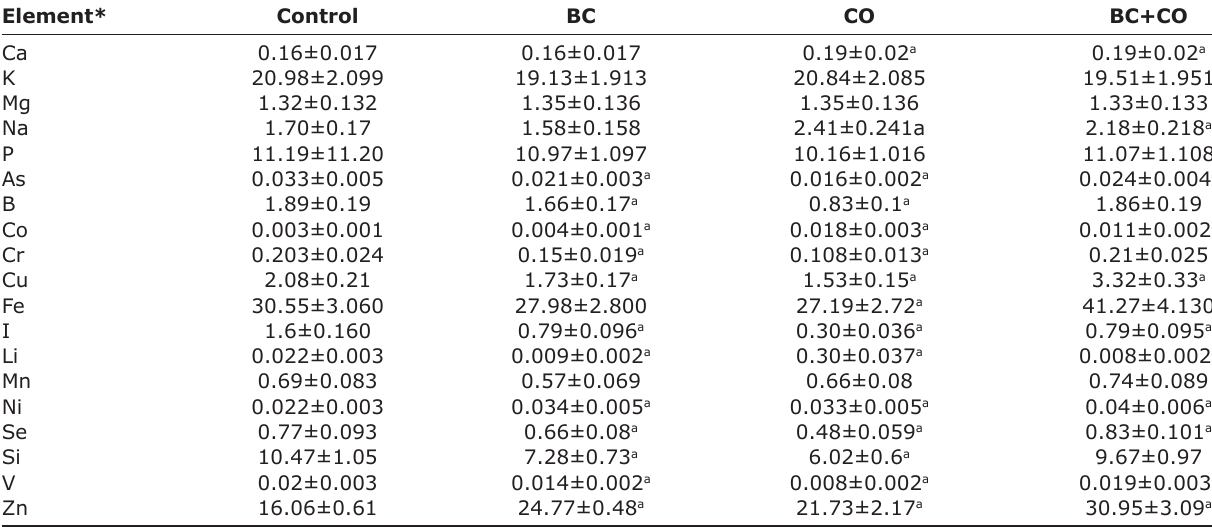
Table-7: Concentrations of chemical elements in the thoracic muscles of broilers with Bacillus cereus and coumarin in diets (day 42). Element*